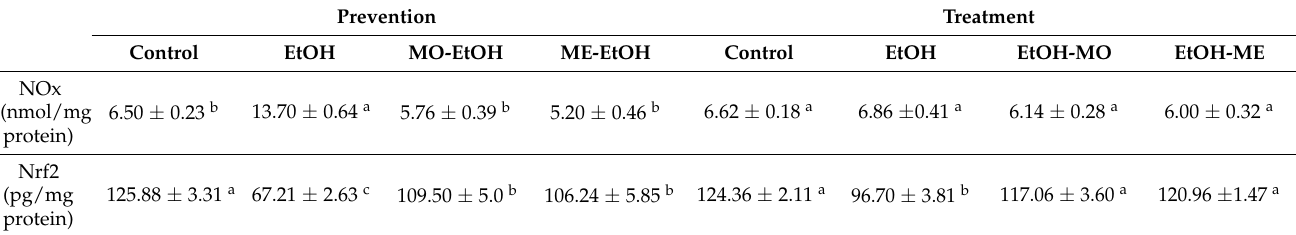
Table 7. Effect of myrrh oil and myrrh extract on NOx and